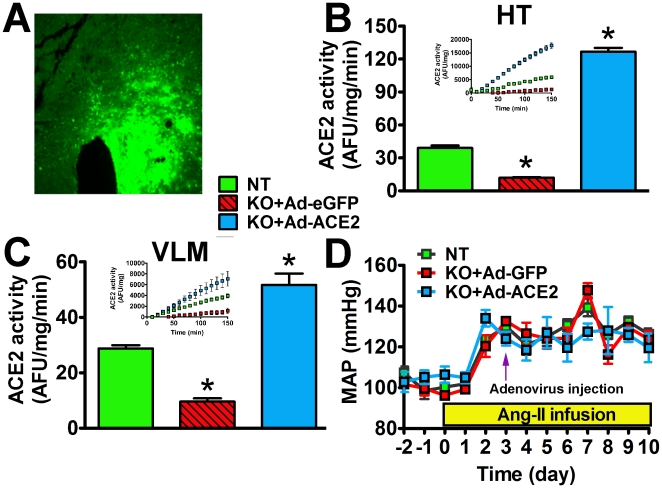
ACE2 expression, activity and MAP in ACE2−/y mice following ACE2 gene therapy to the PVN.Immunohistochemistry (A) showing green fluorescent protein (eGFP) expression targeted to the PVN, 7 days after unilateral administration of adenovirus. ACE2 activity in HT (B) and VLM (C) was significantly lower in ACE2−/y than NT mice (*P<0.01, n = 4). Seven days after ACE2 bilateral adenovirus injection to the PVN, ACE2 activity was significantly increased in HT and downstream VLM in KO mice (*P<0.01 vs. NT, n = 4). Ad-hACE2 injected in the PVN of ACE2−/y on the 3rd day of AngII infusion did not alter the course of the developing hypertension (D, P>0.05, n = 8).